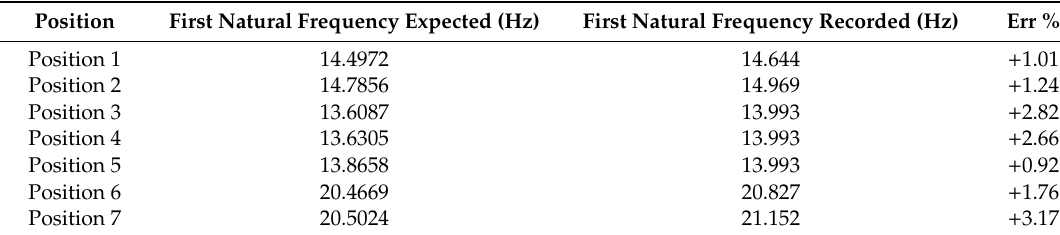
Table 2. Comparison of the first natural frequency in the seven reference positions obtained by applying